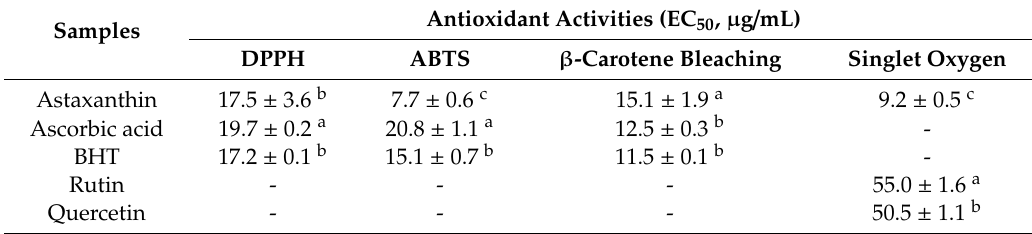
Table 1. Antioxidant properties of astaxanthin extract as measured by di ff erent antioxidant assays